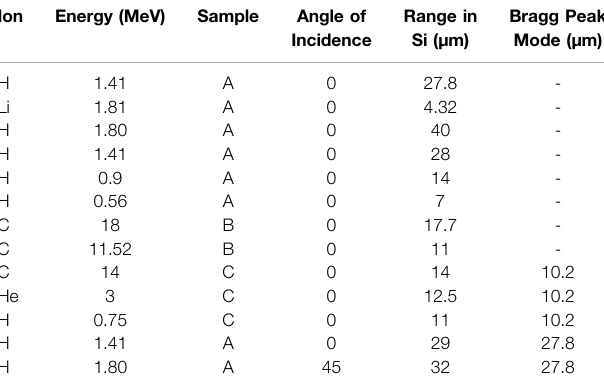
TABLE 1 | List of the experimental conditions used in 5 experimental sessions of IBICmeasurementsperformedon3differentLGADsamplesexplainedintext. Ion Energy (MeV)